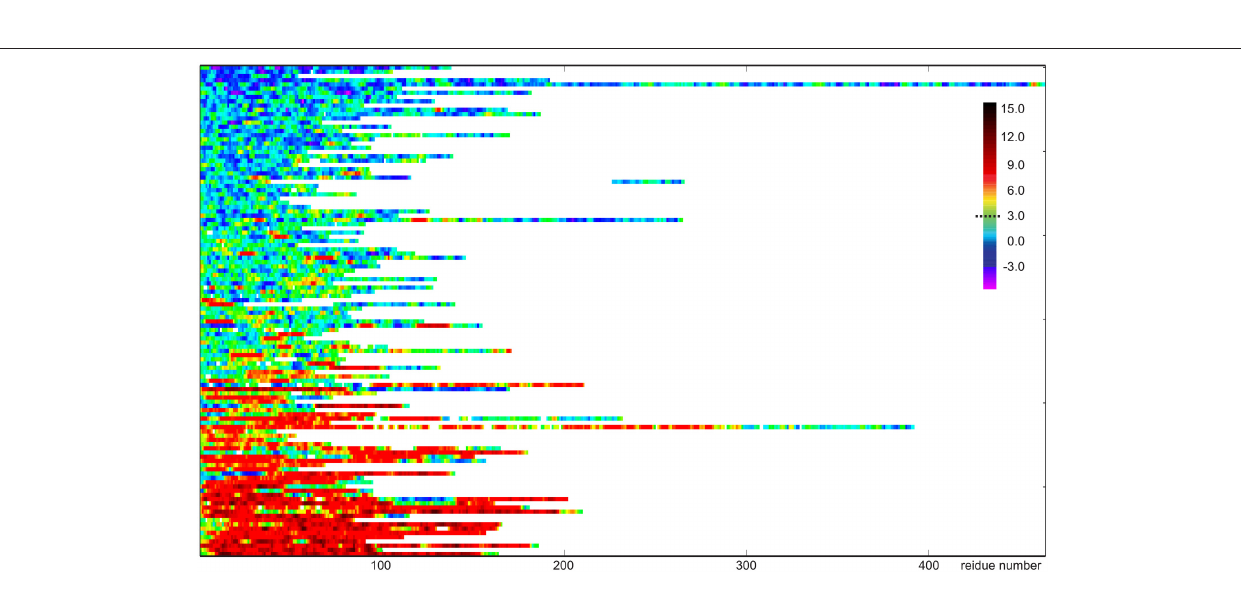
FIGURE 2 | Visualization of disorder profiles for the 117 proteins sequences in the CheZOD database. Each row represents a single protein where disordered residues ( Z IDR < 3) are shown in blue, ordered residues ( Z IDR > 3) are shown in red, and residues with average order shown in green/yellow. The proteins are depicted from top to bottom sorted according to the average of Z IDR for the